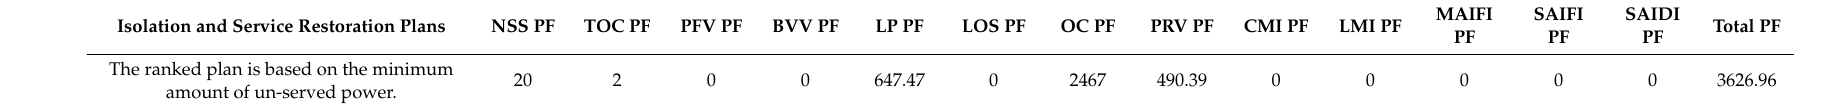
Table 18. Performance factors (PF) of the FLISR approach with respect to a DPGF at